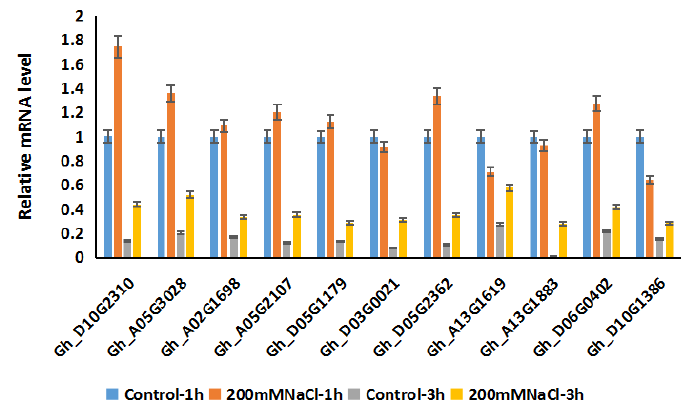
Figure 10. Expression profile analysis of Gh_D10G2310 , Gh_A05G3028, and co-expressed genes under salt stress. The expression levels of Gh_D10G2310 , Gh_A05G3028, and co-expressed genes related to salt resistance under control and salt stress at 1 and 3 h. Control-1 h: 1 h after watering with 1/2 MS liquid medium, NaCl-1 h: 1h after watering with 1/2 MS liquid medium containing 200 µ m NaCl, Control-3 h: 3 h after watering with 1/2 MS liquid medium, NaCl-3 h: 3 h after watering with 1/2 MS liquid medium containing 200 µ m NaCl. Error bars represent the standard deviation of the three biological replicates.